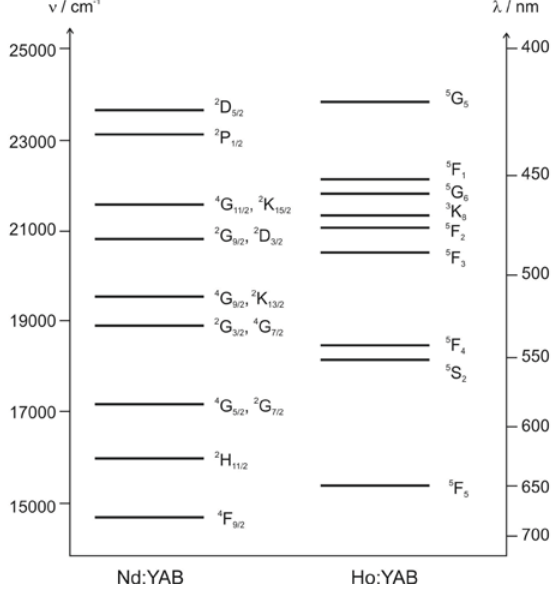
Figure 3. Ho:YAB and Nd:YAB free ion barycentre energy level diagrams, level assignments according to [27] and [7],